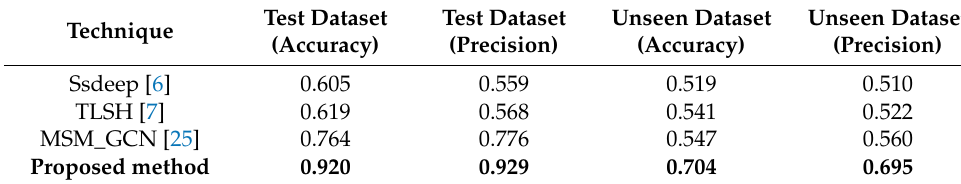
Table 6. Similarity model performance comparison with previous works.